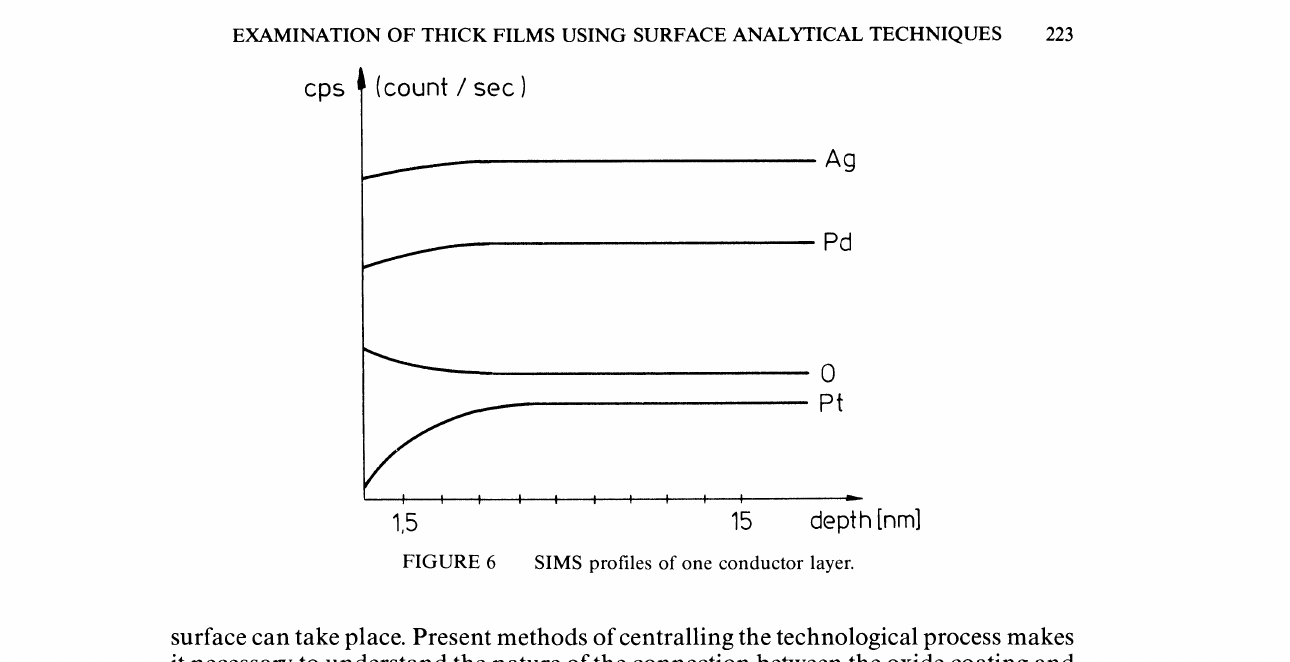
15 depth [nm] FIGURE 6 SIMS profiles of one conductor